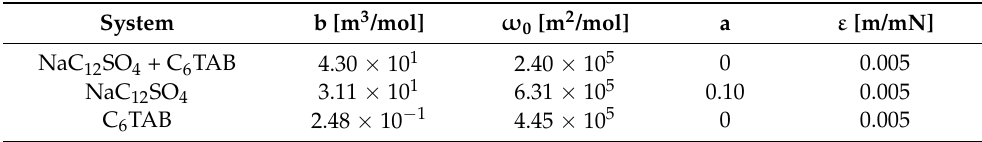
Table 5. Parameter values obtained by fitting the Frumkin adsorption model Equations (1)–(3) to the experimental data of Figure